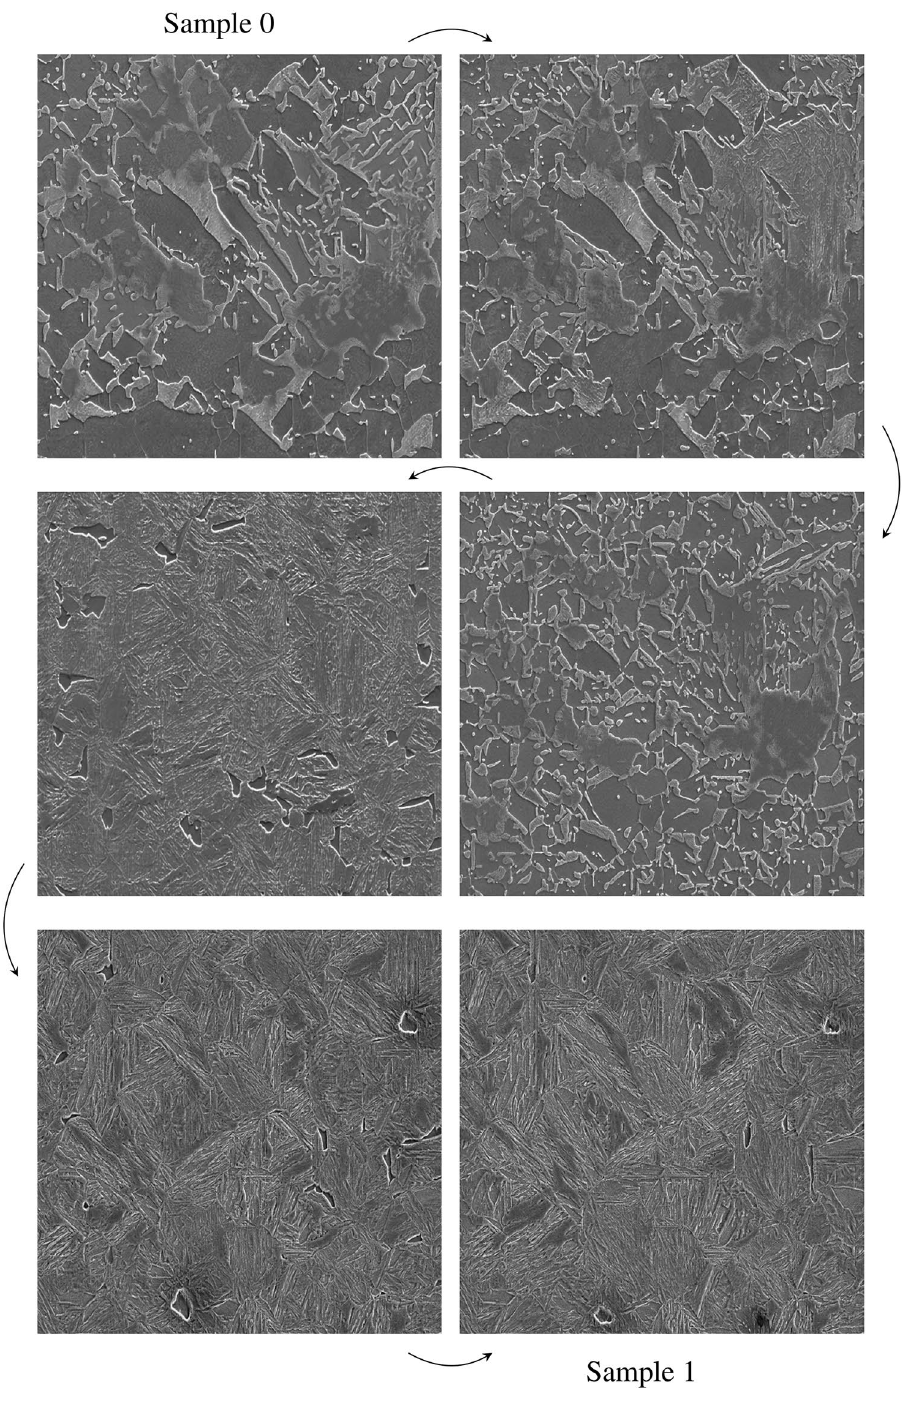
Figure 5. Selection of 4 non-curated generated SEM images obtained thanks to a spherical linear interpolation 38 between sample 0 (top-left corner) and sample 1 (bottom-right corner), themselves generated from two random numerical vectors of 512 dimensions fed as input to the StyleGAN2 trained with ADA 8 from scratch on 3000 SEM images. The direction of the sequential flow from one interpolated image to another is illustrated with an arrow. A one-minute smooth video of this sequence is available online (see Data